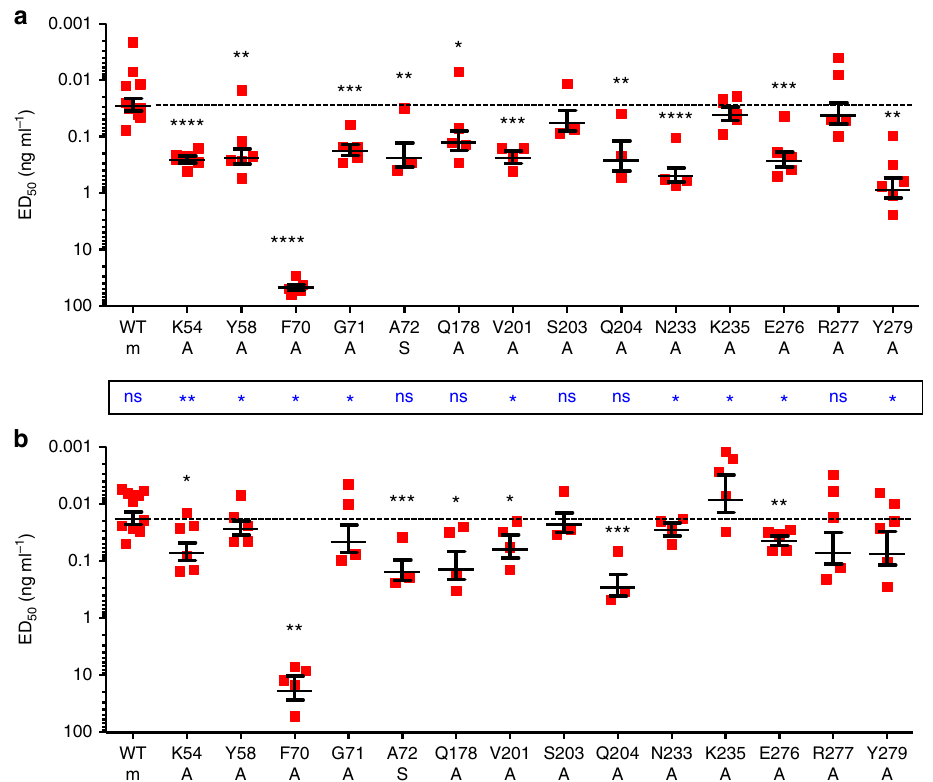
Fig. 3 IL3R α site 1b residues are a functional hotspot in mediating IL-3 signalling. Functional activity of IL3R α mutants was measured in a wild-type IL-3 or b IL-3 K116W dose – response proliferation assays using CTLL-2 cell lines transduced to co-express the β c subunit with either wild-type or mutant forms of IL3R α . The identity of each IL3R α mutant is shown along with the substituted residue (m). Half-maximal responses (ED 50 ) were calculated from each experiment and averaged. The dashed line represents the response from cells expressing wild-type IL3R α . Errors represent SEM. Statistical signi fi cance of differences in functional response between wild-type IL3R α and the mutant forms of IL3R α ( p ) was determined using a two-tailed unpaired t test and are shown as black asterisks above the data for each mutant. Statistical signi fi cance of differences in functional response between wild-type IL-3 and IL-3 K116W ( p ) was also determined using a two-tailed unpaired t test and are shown as blue asterisks between data sets a and b . ns p > 0.05, * p < 0.05, ** p < 0.01, *** p < 0.001, **** p <